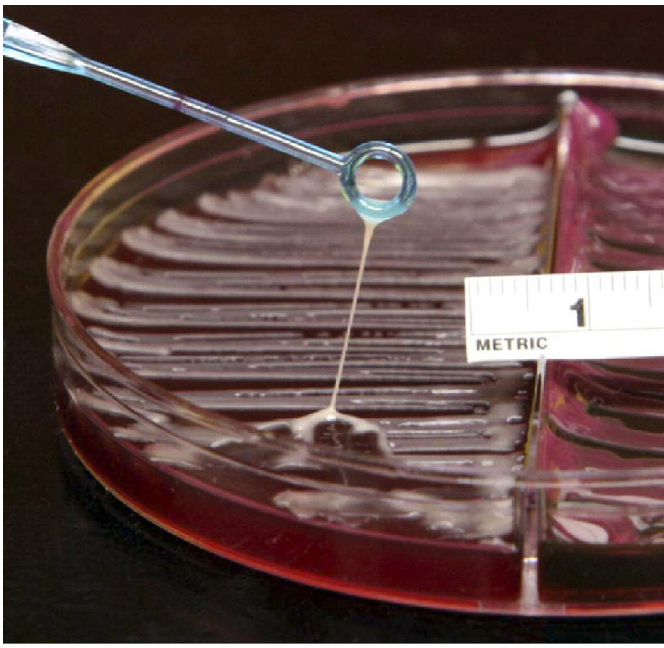
Figure 2. Example of a positive string test (>5mm string) indicating the hypermucoviscous